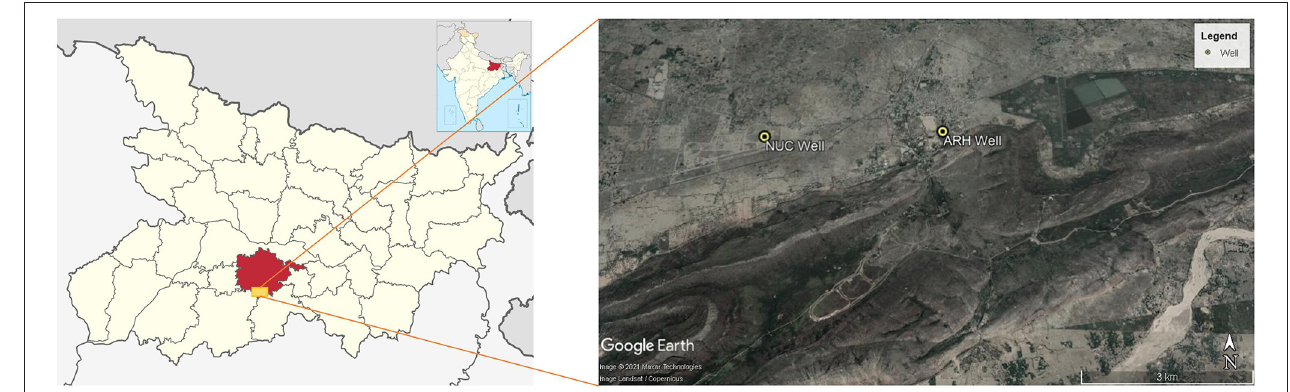
FIGURE 1 | Location map (using Google Earth) showing well sites at the Nalanda University Campus (NUC) and Ajatshatru Residential Hall (ARH), Rajgir, Nalanda, Bihar, India (inset: shows Bihar in